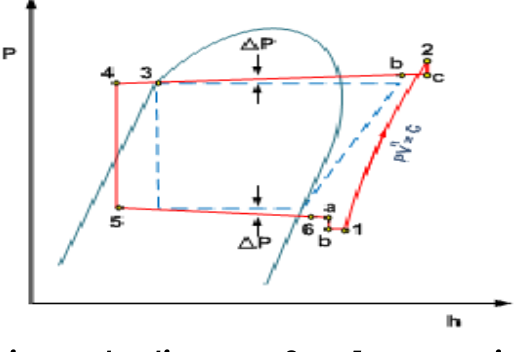
Fig.3: p-h diagram of real compression